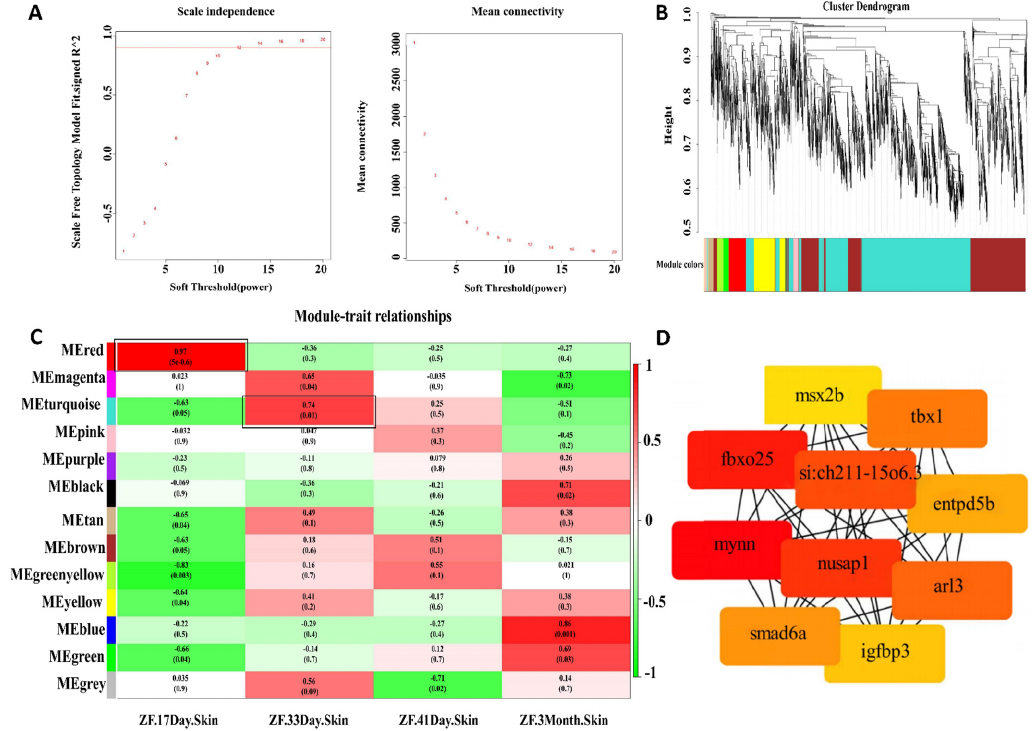
Figure 3. WGCNA analysis and hub-gene identification. ( A ) Network topology analysis of various soft threshold powers. The left figure shows the relationship between the scale-free fitting index (Y − axis) and the soft threshold capability (X − axis). The right graph shows the relationship between average connectivity (Y − axis) and soft threshold power (X − axis). ( B ) Clustering tree graph of genetic system based on topological overlap. Based on the dissimilarity of topological overlap, genes were classified into 13 different modules, where each color represents a module. ( C ) Correlation heat map between gene co-expression network module and different developmental stages of scales. ( D ) The top 10 hub-gene networks. The color intensity in the figure represents the connectivity; the darker the color, the more important it is.